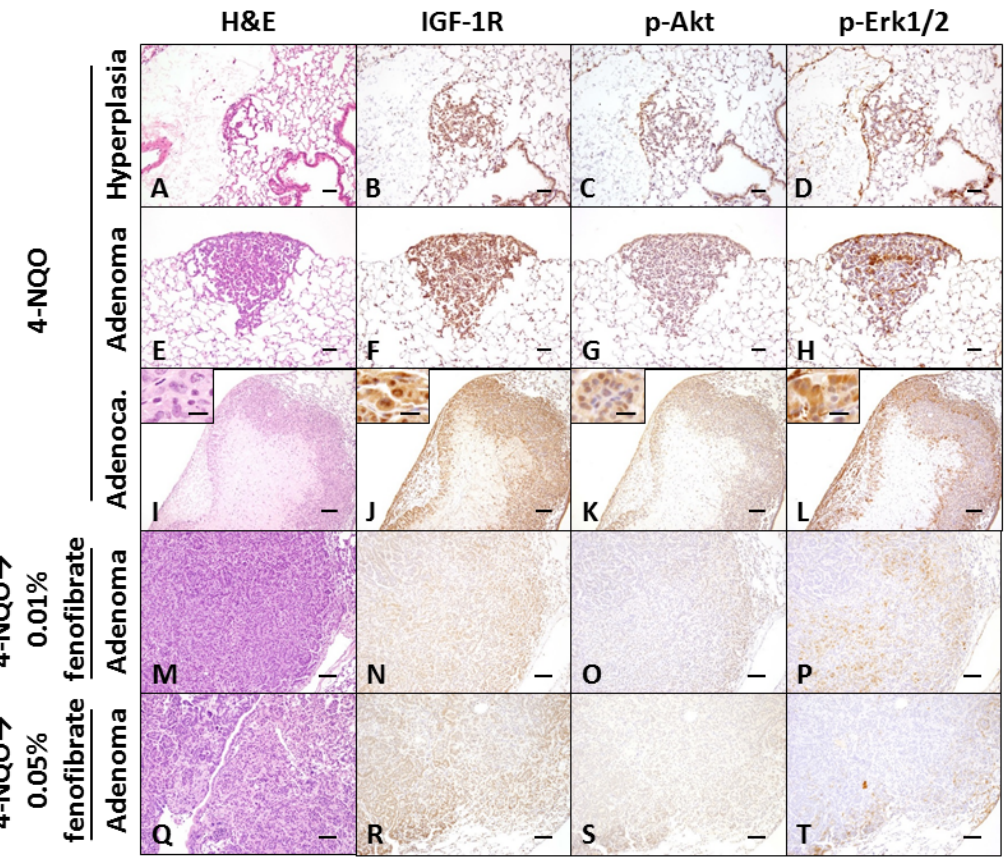
2.1.3. Immunohistochemical Expression of IGF-1R, p-Akt, p-Erk1/2, PPAR α , and PPAR γ in Pulmonary Proliferative Lesions Induced by 4-NQO The immunohistochemical expression levels of IGF-1R, p-Akt, and p-Erk1/2 were examined in 4-NQO-induced pulmonary proliferative lesions (Figure 2). 4-NQO induced the expression of IGF-1R, p-Akt, and p-Erk1/2 in all proliferative lesions, and the expression levels of IGF-1R and p-Erk1/2 were greater than the levels of p-Akt in each lesion, as shown in Figure 2. Expression of IGF-1R, p-Akt, and p-Erk1/2 was weak or lacking in the adenomas by the treatment with fenofibrate. Figure 2. Histopathology ( A , E , I , M , Q ) and immunohistochemistry (insulin-like growth factor 1 receptor (IGF-1R), phosphorylated (p)-Akt, and p-extracellular signal-related kinase (Erk) 1/2) of bronchioloalveolar hyperplasia ( B – D , N , O , P , R – T ), adenoma ( F – H ), and adenocarcinoma ( J – L ) induced by 4-nitroquinoline 1-oxide (4-NQO) administration in Tsumura Suzuki Obese Diabetic (TSOD) mice. The adenomas M – P and Q – T are developed in a mouse treated with 4-NQO followed by dietary exposure to 0.01% and 0.05% fenofibrate, respectively. Alveolar hyperplasia ( A – D ), adenoma ( E – H ), and adenocarcinoma ( I – L ) were positively stained with IGF-1R ( B , F , J ), p-Akt ( C , G , K ), and p-Erk1/2 ( D , H , L ) antibodies, respectively. Note the weakly positive or negative reactions against IGF-1R, p-Akt, and p-Erk1/2 of adenoma in mice that received 4-NQO and fenofibrate. ( A , E , I , M , Q ): H&E stain; ( B , F , J , N , R ): IGF-1R immunohistochemistry; ( C , G , K , O , S ): p-Akt immunohistochemistry; and ( D , H , L , P , T ): p-Erk1/2